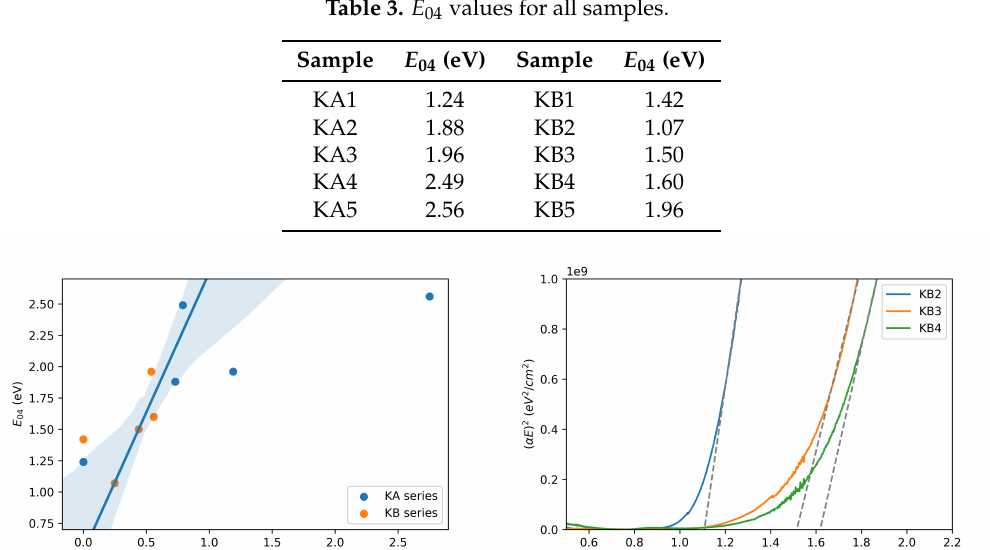
Figure 6. E 04 plot in terms of the EDX Mg measured atomic ratio ( left ) and Tauc plot for the partially substituted samples of the KB series ( right